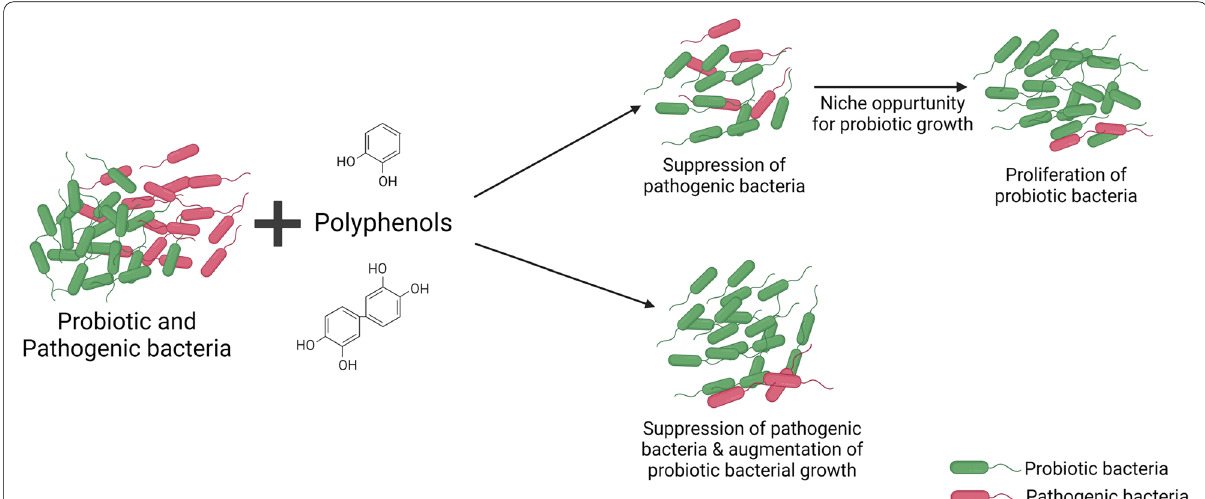
Fig. 3 Influence of food polyphenols on microbial population. Polyphenols suppress the growth of opportunistic pathogens that ultimately allows for the proliferation of probiotic bacteria. In addition, polyphenols may directly augment the growth of probiotic bacteria while still suppressing pathogenic growth thereby favorably reshaping the microbial community structure of